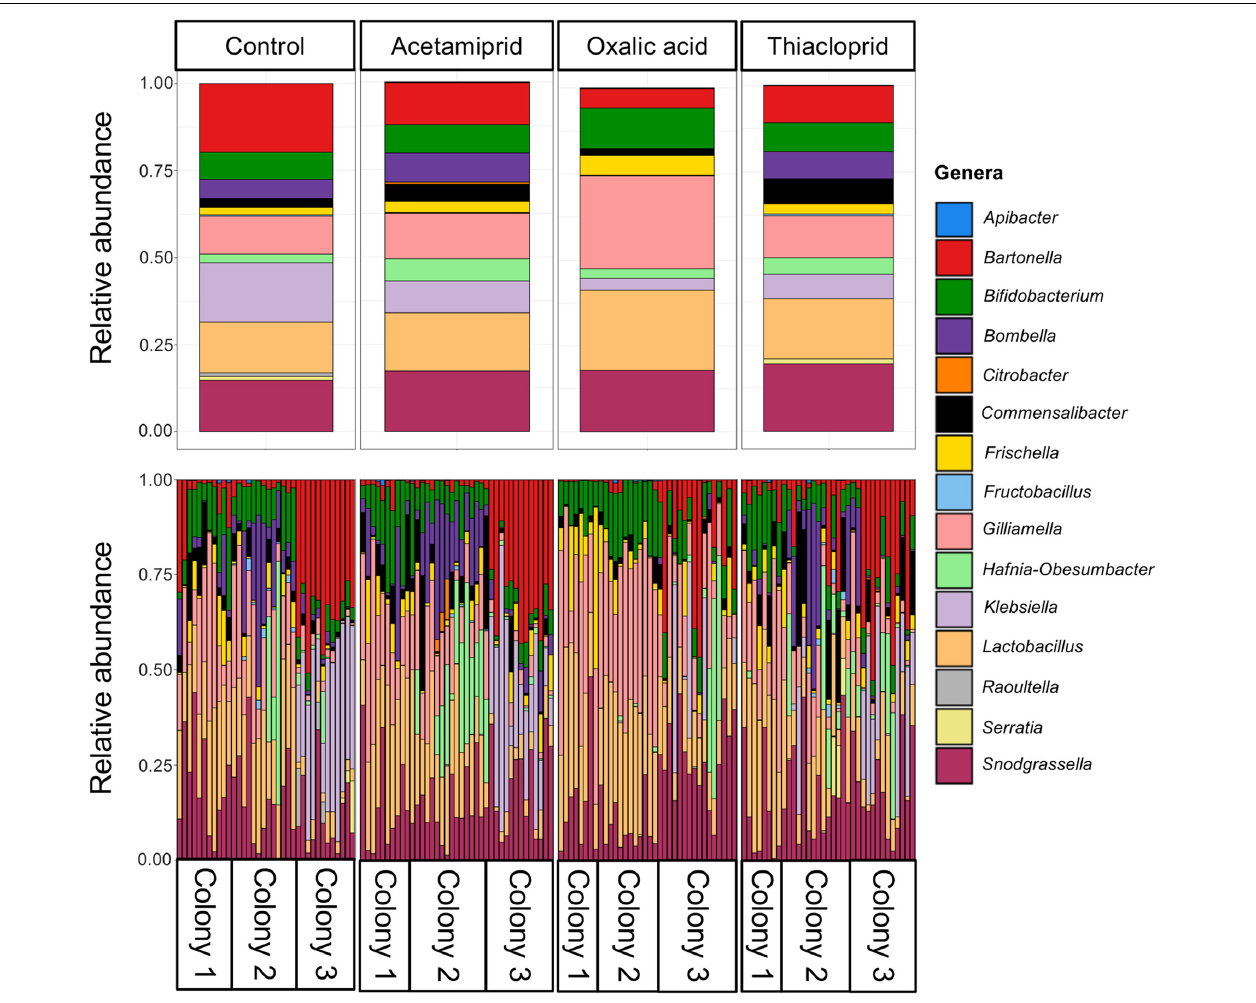
FIGURE 5 | Relative abundances of the 15 most abundant bacterial genera across the full dataset. The top panel gives relative abundances by treatment, while the bottom panel gives the relative abundances per honeybee gut, illustrating the abundant variation across samples within and between